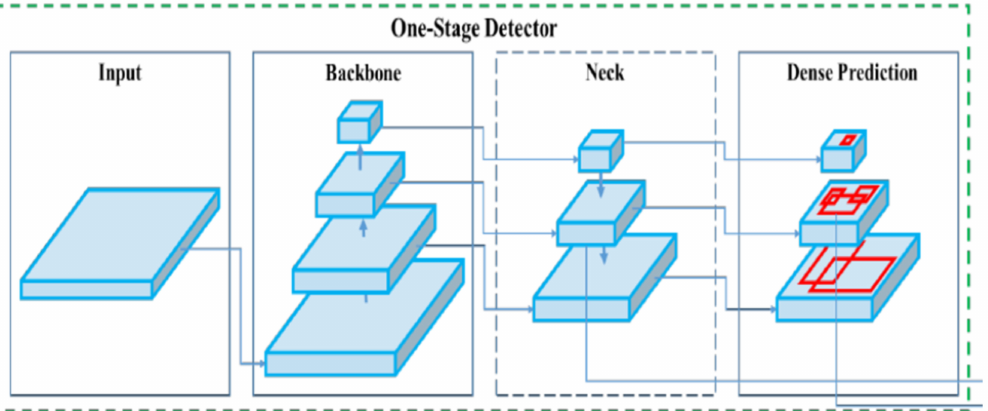
Figure 4. Yolov4 structure (adapted from [24]: Bochkovskiy, A.; Wang, C.-Y.; Liao, H.-J.M. YOLOv4 Optimal Speed and Accuracy of Object Detection. arXiv 2020 , arXiv:2004.10934, with permission from Cornell